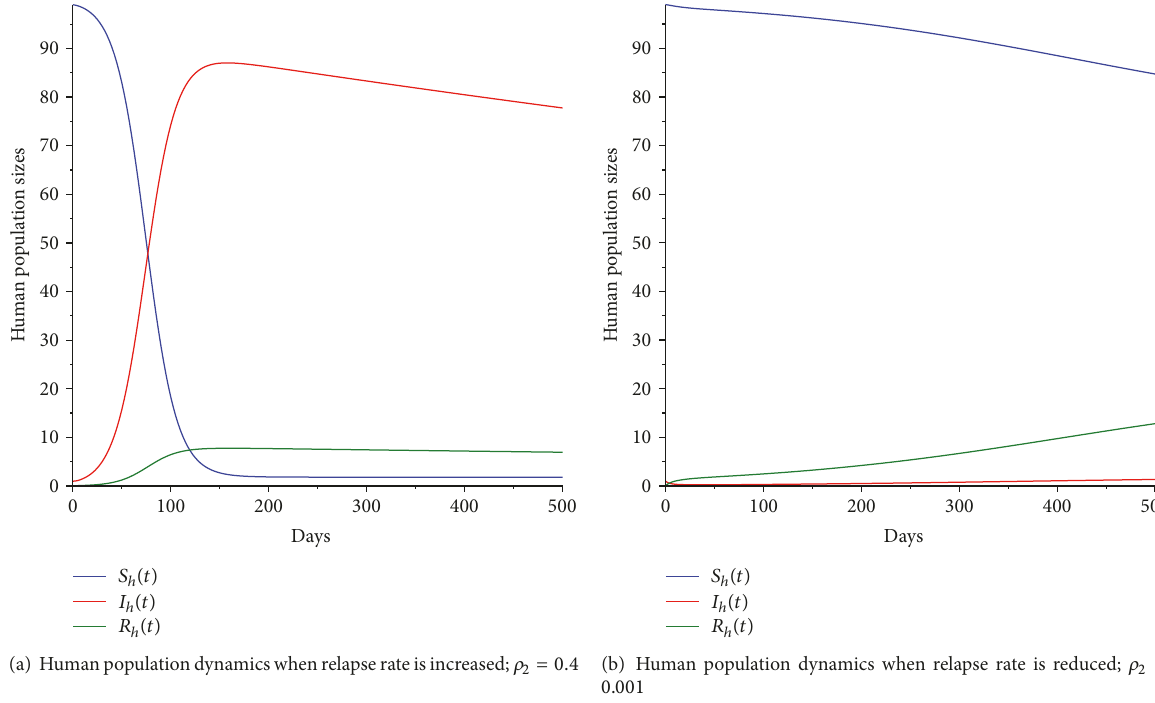
(b) Human population dynamics when relapse rate is reduced; 𝜌 2 = 0.001 Figure 7: Changing effects of relapse on the human